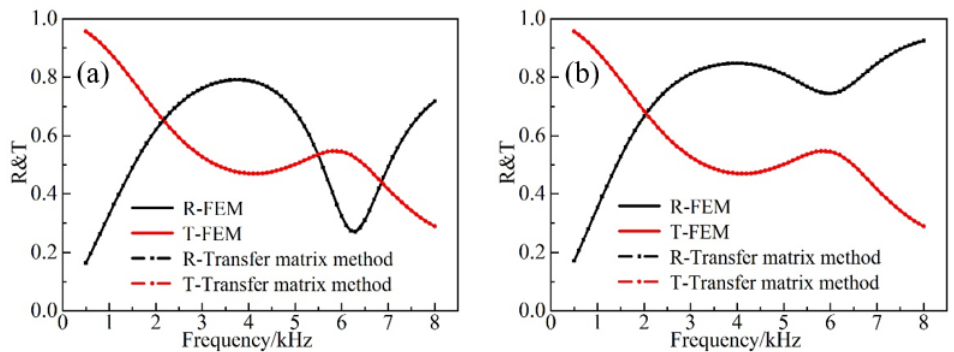
Figure 4. Comparison of the FEM and the analytical methods in ( a ) forward and ( b ) backward incidence.